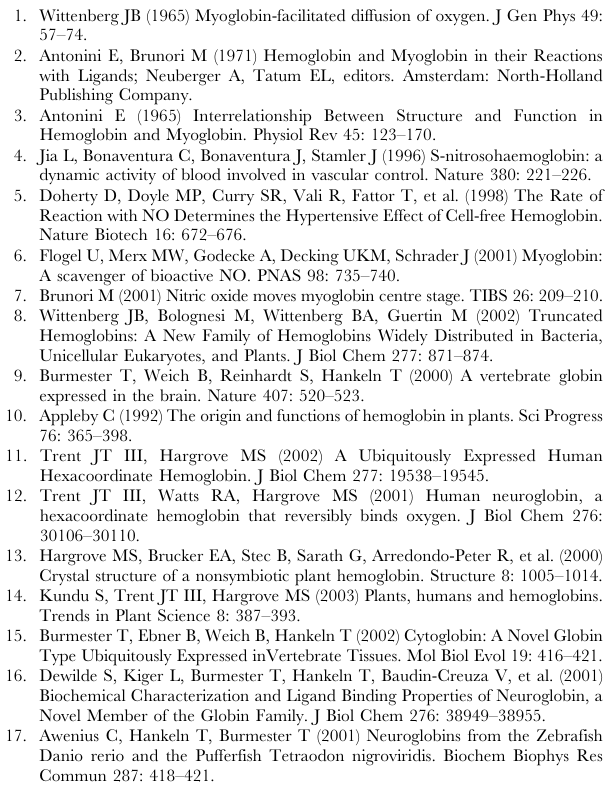
Figure S1 Photolysis inactivation of GSNO